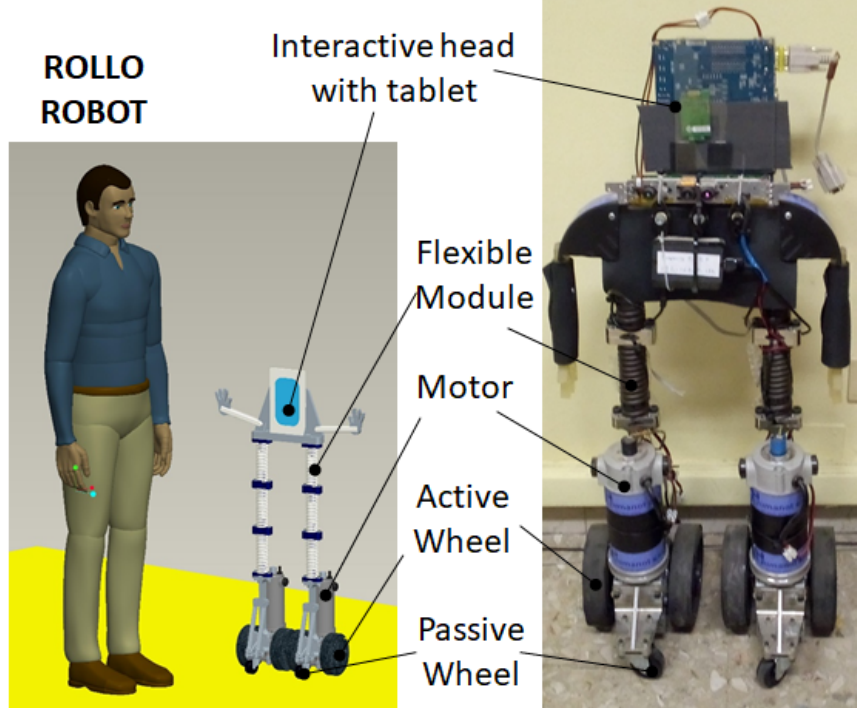
Figure 1. Flexible-wheeled biped robot Rollo. Rollo design requires modifications to attenuate the undesired head